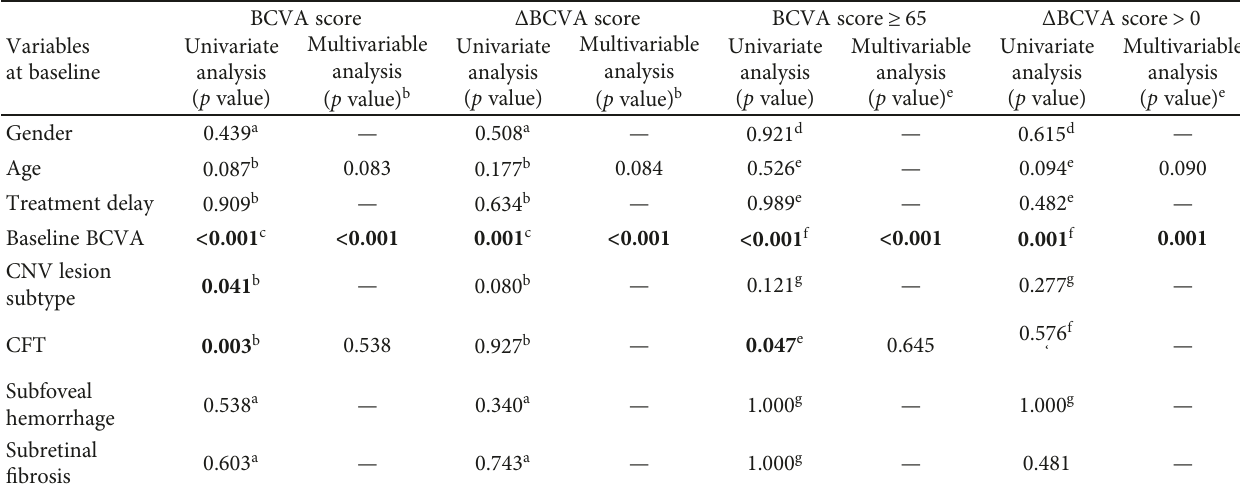
Table 3: Univariate and multivariate analysis for prediction of visual outcomes at 12